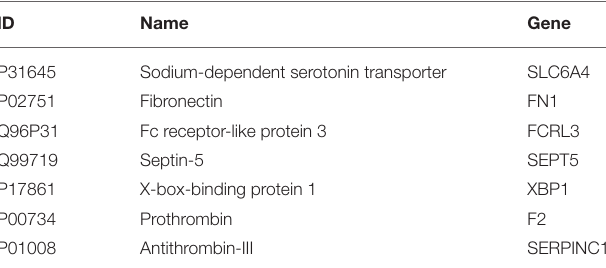
TABLE 2 | Novel proteins specifically expressed in